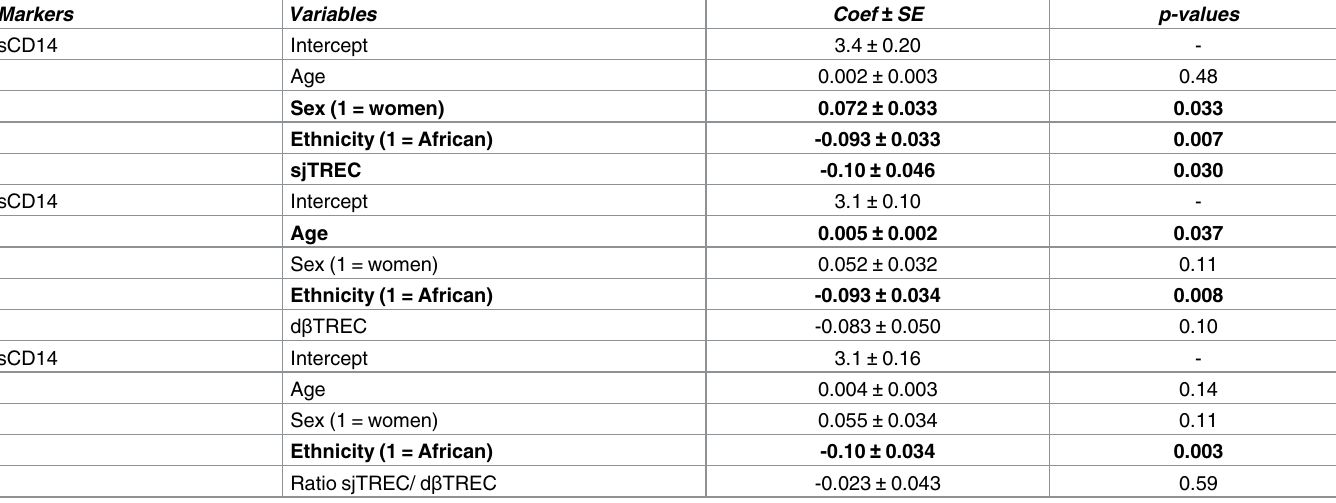
Table 4. Impact of TRECs on sCD14 (N = 75), taking into account patients’ characteristics * .